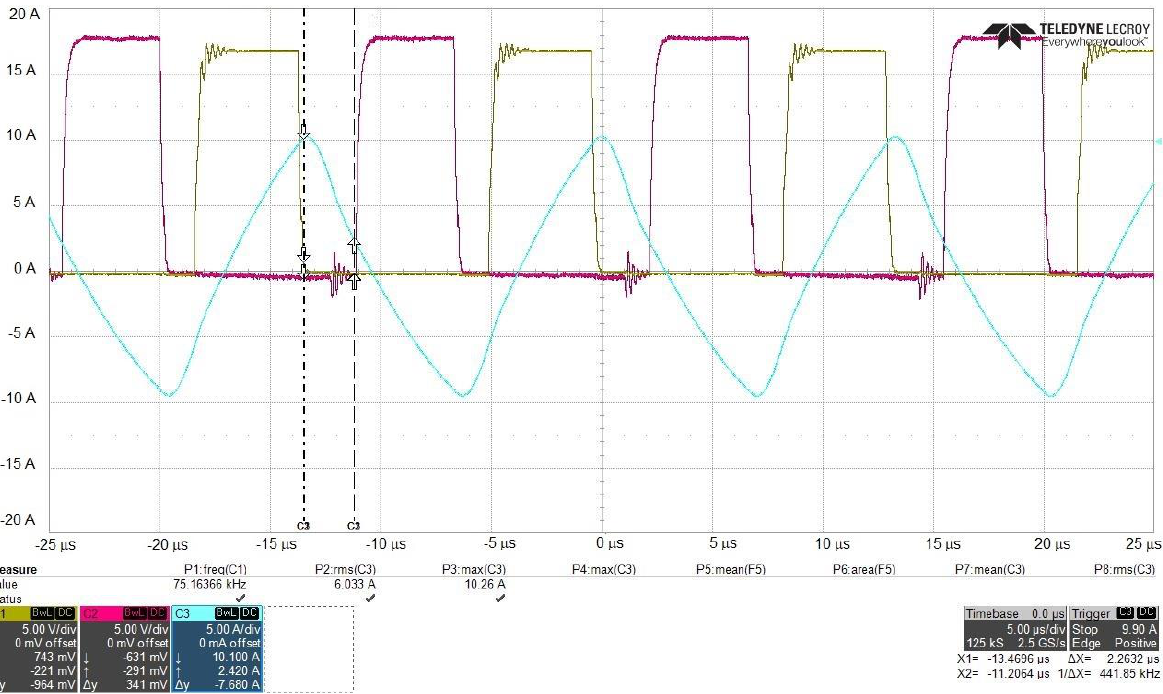
Figure 31. Receiver coil voltage (C1, green) and current (C2, purple) at 26.